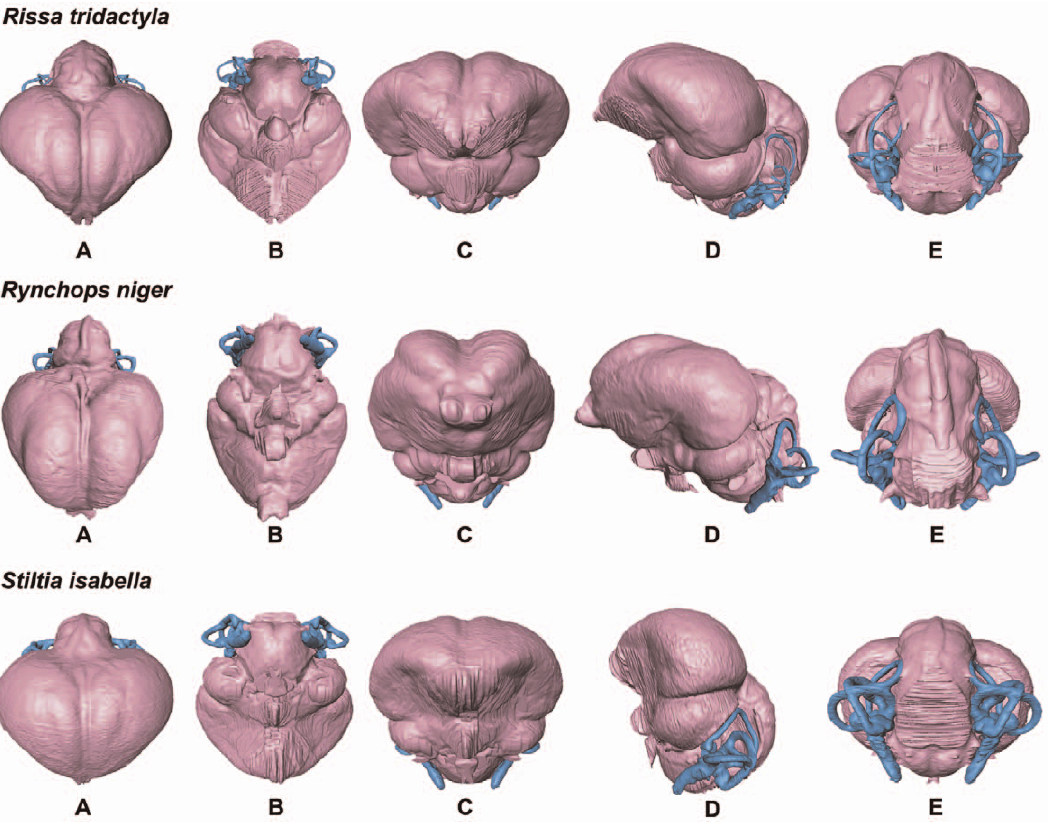
Figure 8. Endocasts of the Black-legged Kittiwake Rissatridactyla , Black Skimmer Rynchopsniger , and Australian Pratincole Stiltia isabella in dorsal (A), ventral (B), anterior (C), lateral (D), and posterior (E) views (not to scale for comparison). cerebellum (13:0), relatively wide cerebellum (16:2), indistinct cerebellar fissures (17:1), contact between the optic tract and the pituitary gland (22:1), and compression of the semicircular canals of the endosseous labyrinth (25:1).